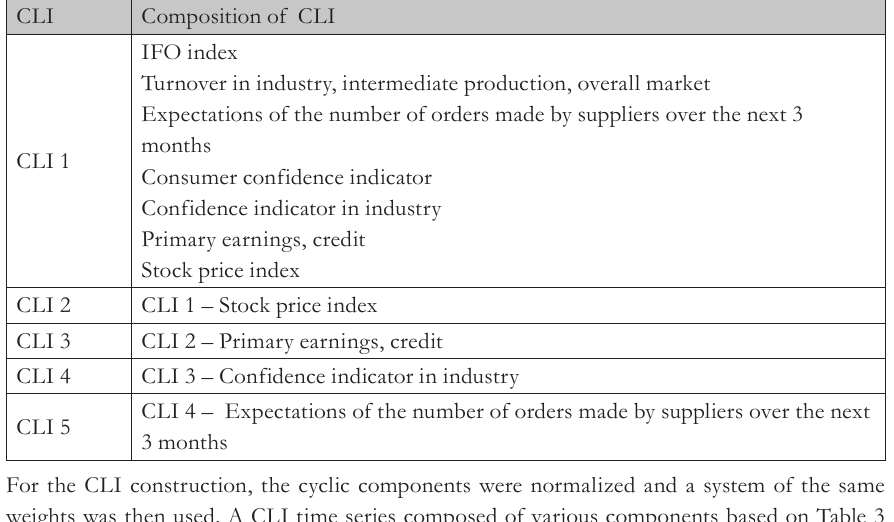
Tab. 3 – Combinations of CLI components. Source: own processing